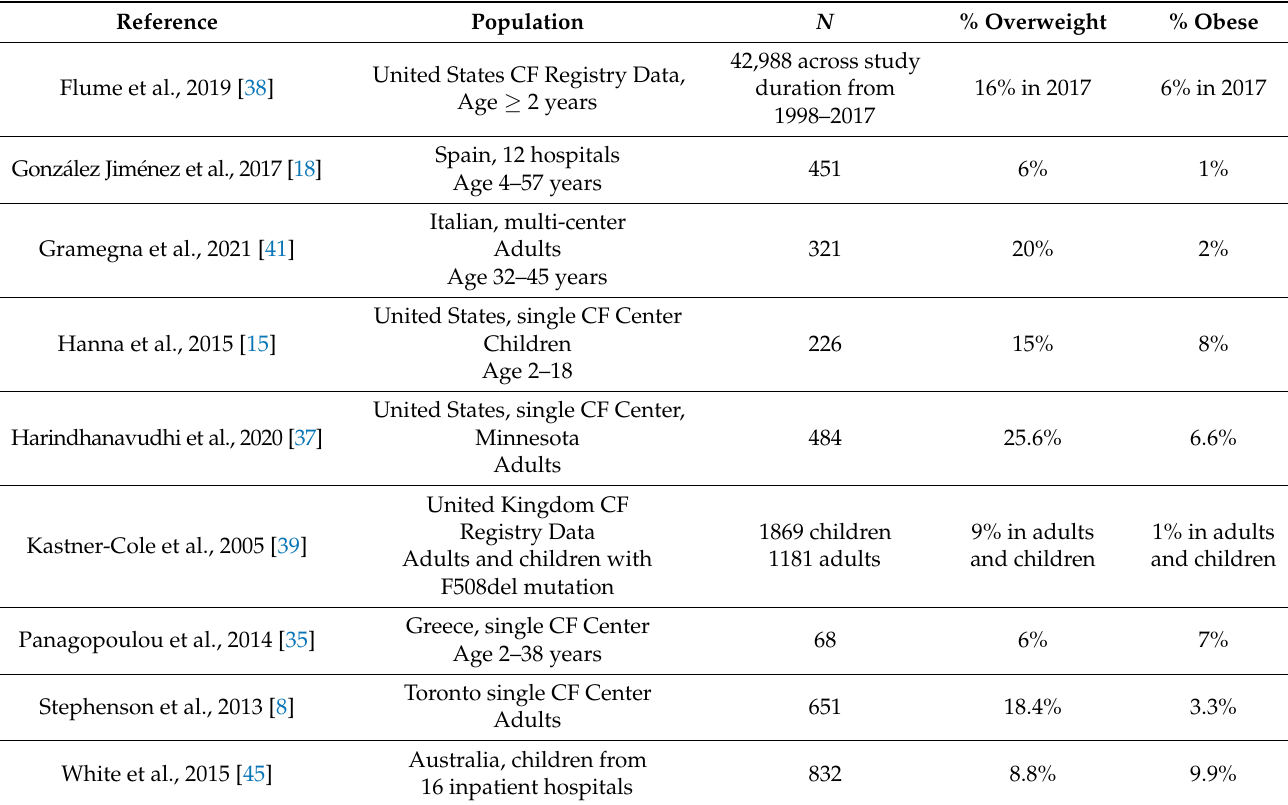
Table 1. Studies examining prevalence of overweight and obesity in